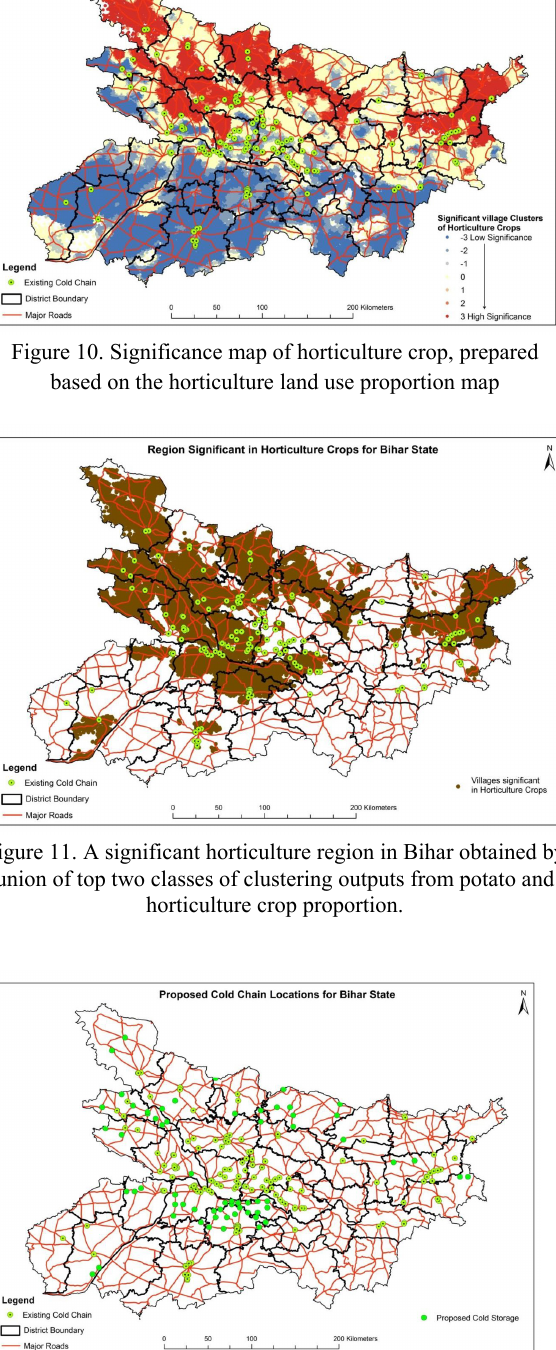
Figure 12. Map showing locations of proposed cold storages and existing cold storages in